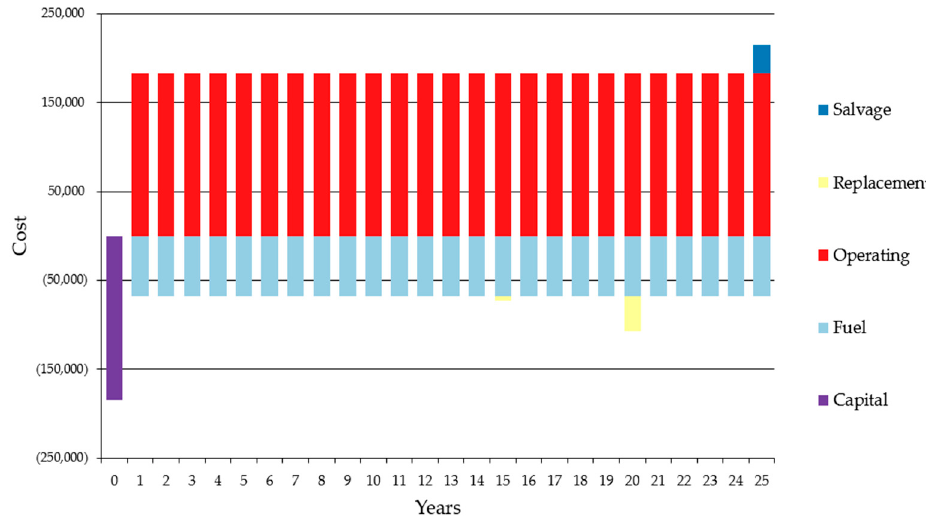
Figure 12. Economic analysis and cashflow of the developed system.